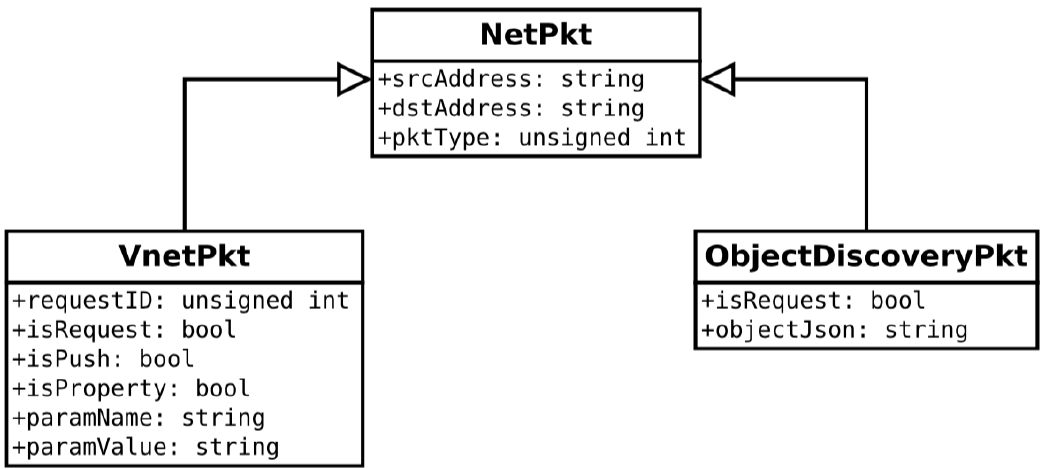
Figure 4. Class diagram of messages used inside the